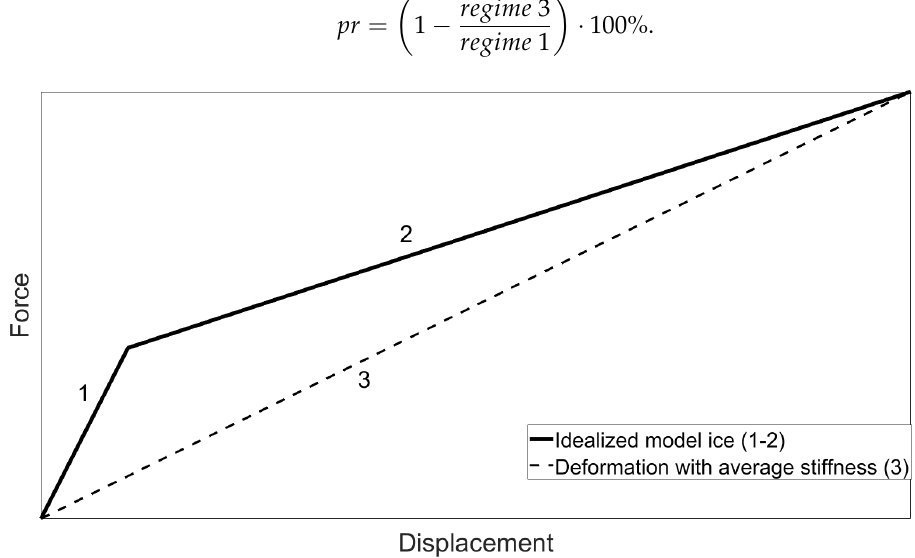
Figure 1. The idealized actual deformation behavior of model ice (regimes 1,2) and the deformation behavior with an average stiffness (regime 3). Note: this is an idealization and regime 2 is usually very